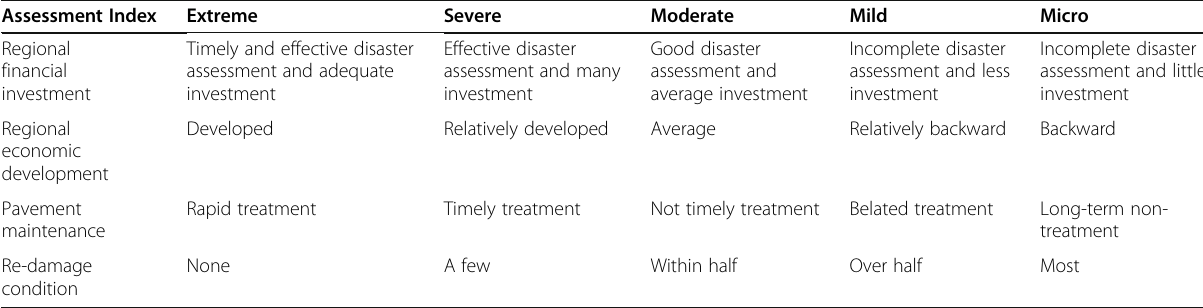
Table 8 Assessment standard of maintenance